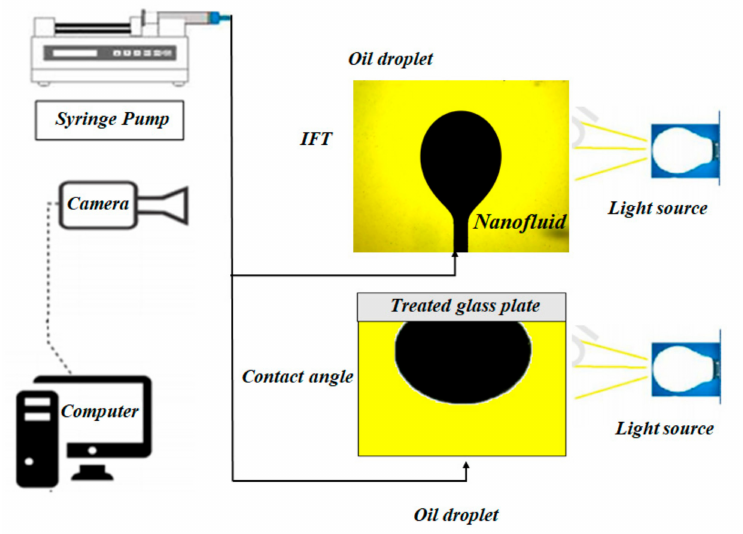
Figure 4. Schematic illustration of the used setups for IFT and contact angle